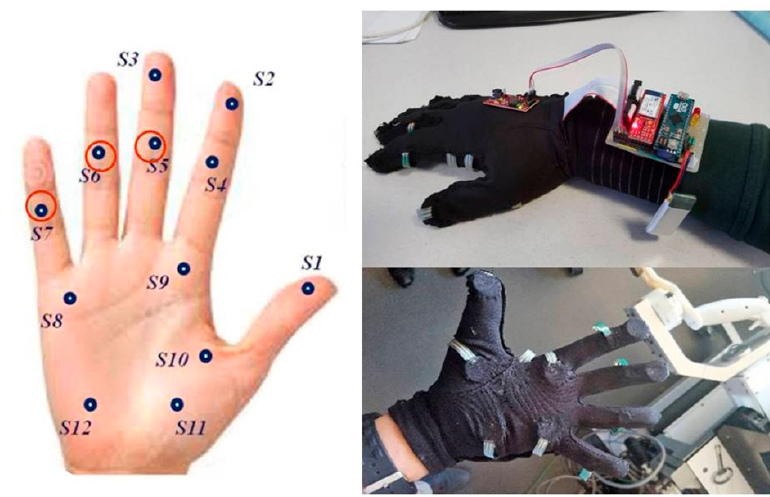
Figure 4. The sensor glove system has twelve sensors positioned mirror-symmetrically across the left and right hands. The spatiotemporal grip-force profiles for expert and novice described under 3.3 in the Results section were drawn from a functionally relevant subset of three sensors (red circles) in the dominant hand, translating optimal grip-force deployment by the pinky (S7), and minimized gross grip-force deployment by the ring and middle fingers (S5, S6) characteristic of expertise in controlling the master–slave system of the surgical robot. The data from ten of the twelve sensors (S2, S3, S5, S6, S7, S8, S9, S10, S11, S12) in the dominant and non-dominant hands of the two users were fed into the variability (standard deviations) and neural network analyses (SOM). Sensors S4 and S1 produced too little significant output and were not taken into account.